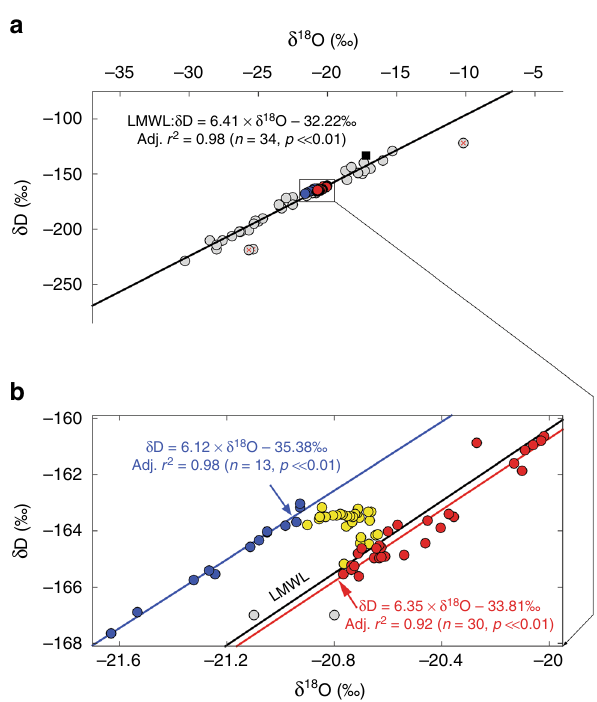
Fig. 4 Precipitation and pore ice isotope climatology. a Monthly δ D precip (see Supplementary Fig. 4 for δ 18 O) and b monthly d excess calculated from Mayo GNIP (Global Network of Isotopes in Precipitation) data (grey circles and 1 σ error bars; excludes suspected evaporation-enriched data points shown in Fig. 3a); Mayo mean annual δ D precip and d excess (dashed black lines), mean DHP174-13 (Dempster Highway Peatland, near 174 km marker) top-of-permafrost (58 – 60 cm) pore ice δ D and d excess (solid red lines) and estimated initial pore water δ D and d excess (dashed red lines) are indicated; c comparison of δ D pore ice (top-of-permafrost) -based temperature estimate (red line; red band = ± 1 σ uncertainty; Methods) and mean monthly (black circles) and mean annual (black dashed line) temperatures at the Ogilvie River Environment Canada station (1971 – 2007 period of record; Supplementary Note 3); d mean total monthly snowfall (white bars; in snow-water equivalent) and rain (black bars) at Ogilvie River. The shaded area represents the average thaw season (i.e. period when mean daily air temperatures are above freezing)